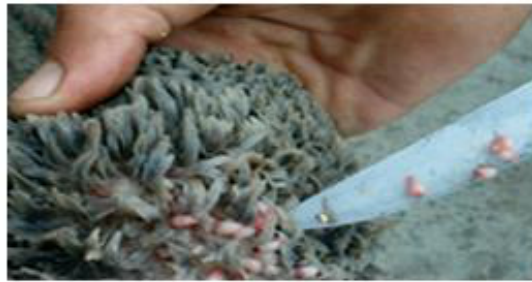
Figure 2. Interstitial nephritis.